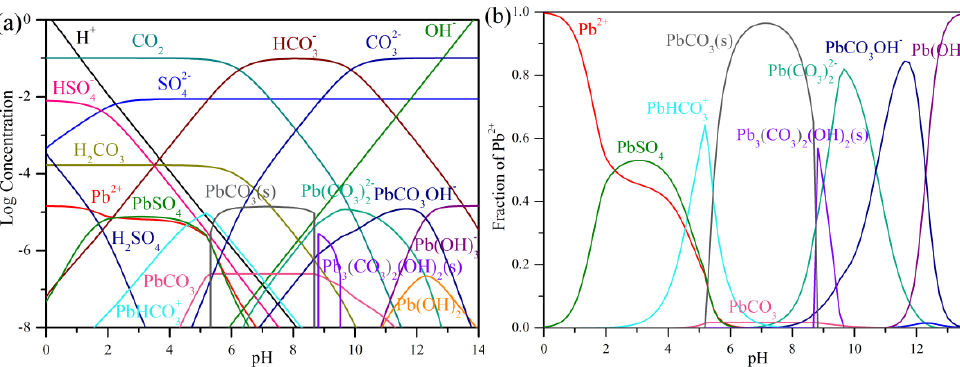
Figure 8. Calculated lead related species distributions of carbonation process with filtration at different pH: ( a ) C CO 2 = 0.1 M with log concentration vs. pH; and ( b ) C CO 2 = 0.1 M with fraction of lead vs. pH.